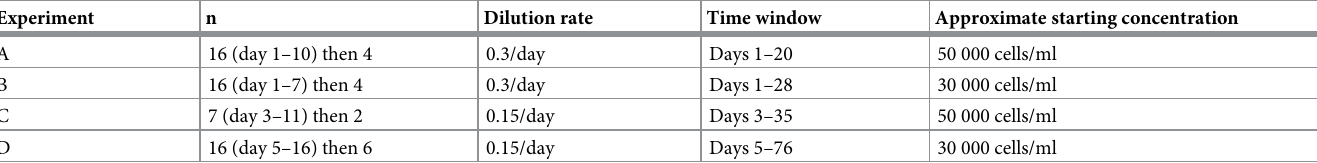
Table 1. Summary of experimental conditions and properties of data used in Figs 1, 3 and